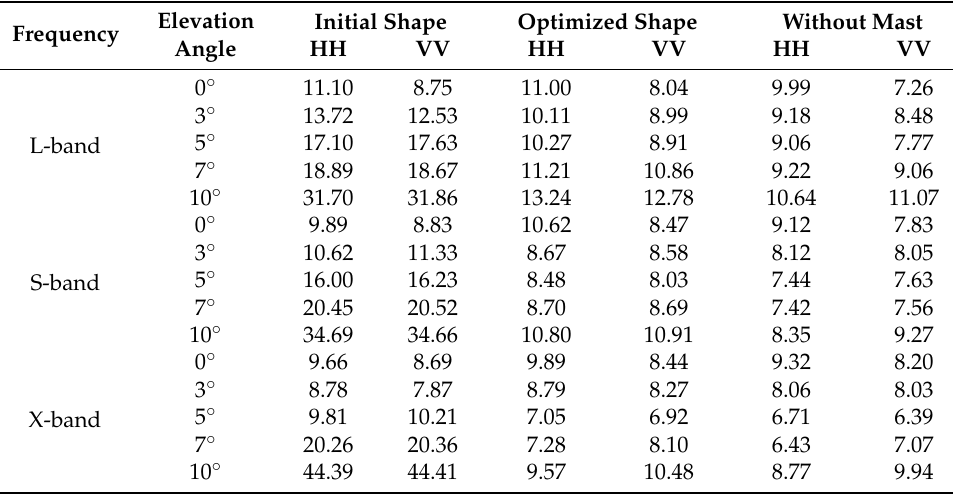
Table 4. Arithmetic mean of a naval vessel equipped with the integrated mast. (Unit: dBsm).